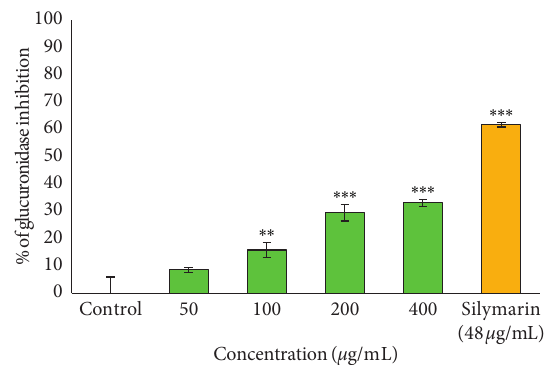
Figure 1: Inhibitory effect of the ethanol extract of B. asphodeloides on beta-glucuronidase activity. Data are presented as the mean ± SD ( n � 3). ∗∗ P < 0 . 01 and ∗∗ ∗ P < 0 . 001 compared to the